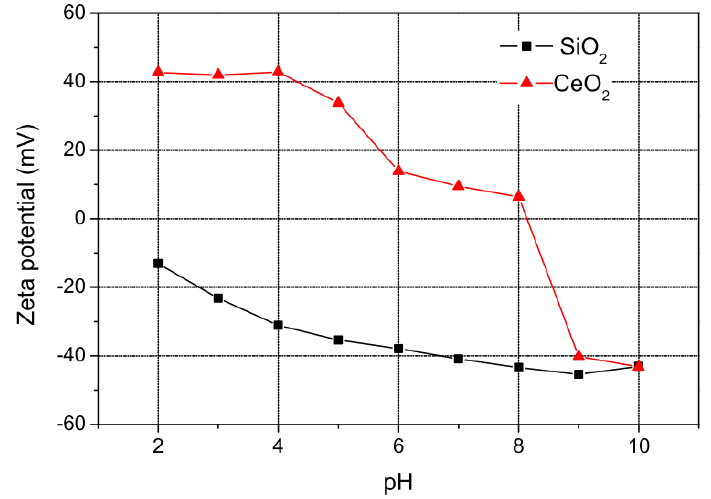
Figure 3. The zeta potentials of CeO 2 and SiO 2 particles in the presence of KMnO 4 [23].